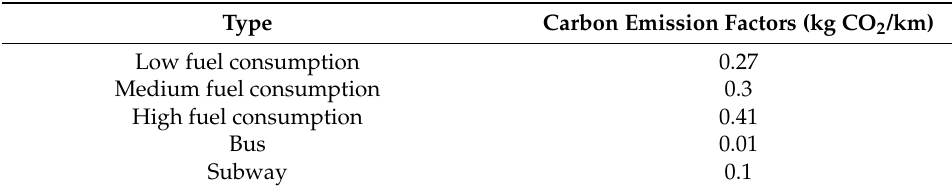
Table 5. Carbon emission factors of each travel mode.